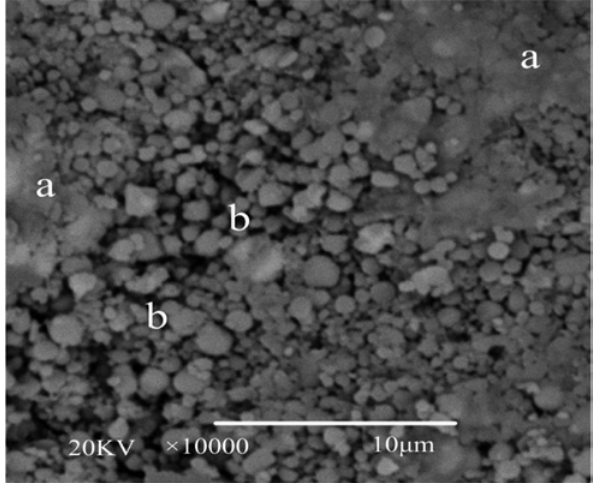
Figure 2: Scanning electron micrographs of zinc oxide dust particles.